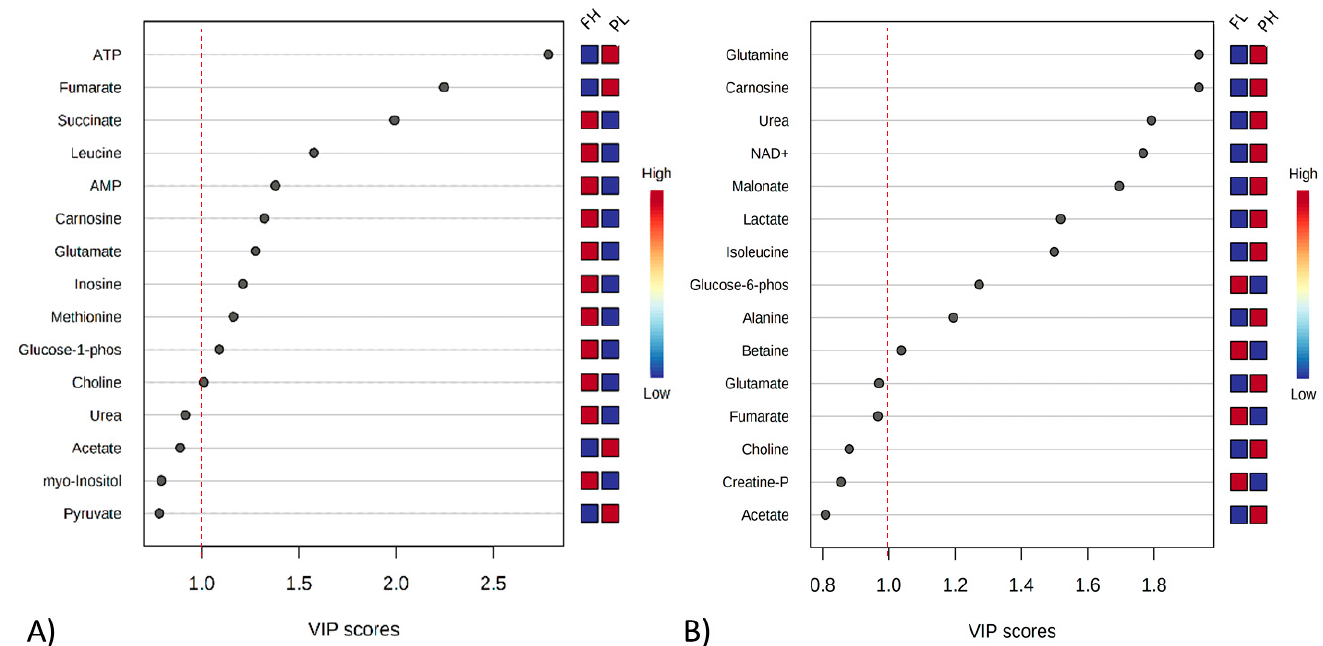
Figure 3. Variable importance in projection (VIP) plot value obtained from meat extracts classified as FH and PL ( A ), and FL and PH ( B ). VIP cut-off of around 1.0. FH: feedlot system with high average daily gain (ADG); (FL) feedlot system with low ADG; (PH) pasture system with high ADG; and (PL) pasture system with low ADG.